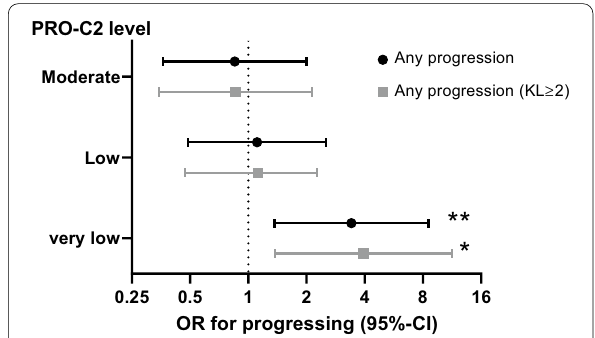
Fig. 3 The odds ratio (OR) for progression in groups of patients with very low (Q1 from Fig. 2), low (Q2), and moderate (Q3) compared with high (Q4) levels of baseline PRO‑C2. Progression was defined as any progression (JSN > 0) over 2‑years in analyses including all subjects Fig. 4 Pharmacodynamic effect of oral salmon calcitonin (sCT) in NYU cohort and the placebo arm of SMC subcohort ( n 185, versus placebo (Pla) on serum PRO‑C2 levels over time in patients = black) and individuals with baseline KL 2 ( n 156, grey). Analyses with low and high baseline PRO‑C2. Data are shown as the mean ≥ = were adjusted for age, BMI, gender, VAS pain, and baseline medial (SEM) percentage difference from baseline. Time dependent effects JSW using logistic regression. Data are presented as OR and 95% were investigated by ANCOVA adjusting for BMI, sex, age, and confidence intervals (CI). Asterisks: ** p < 0.01; * p < 0.05 baseline medial